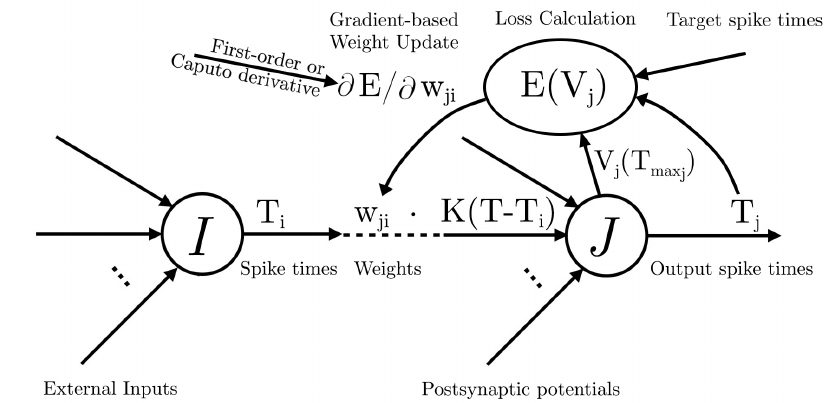
Figure 2. Forward and backward pass for each synapse between two layers of spiking neurons using Tempotron loss. The forward pass includes the calculation of neural dynamics in layer I and J by utilizing K Tempotron kernel function and T i as spike times. w ji weights represent the synapses and are the learnable parameters of this architecture. The network outputs T j spike times of the postsynaptic layer. The backward pass includes the calculation of Tempotron loss according to Equation (3). Then the weights are updated based on the partial derivative ∂ E calculated with an integer or a fractional Caputo order as